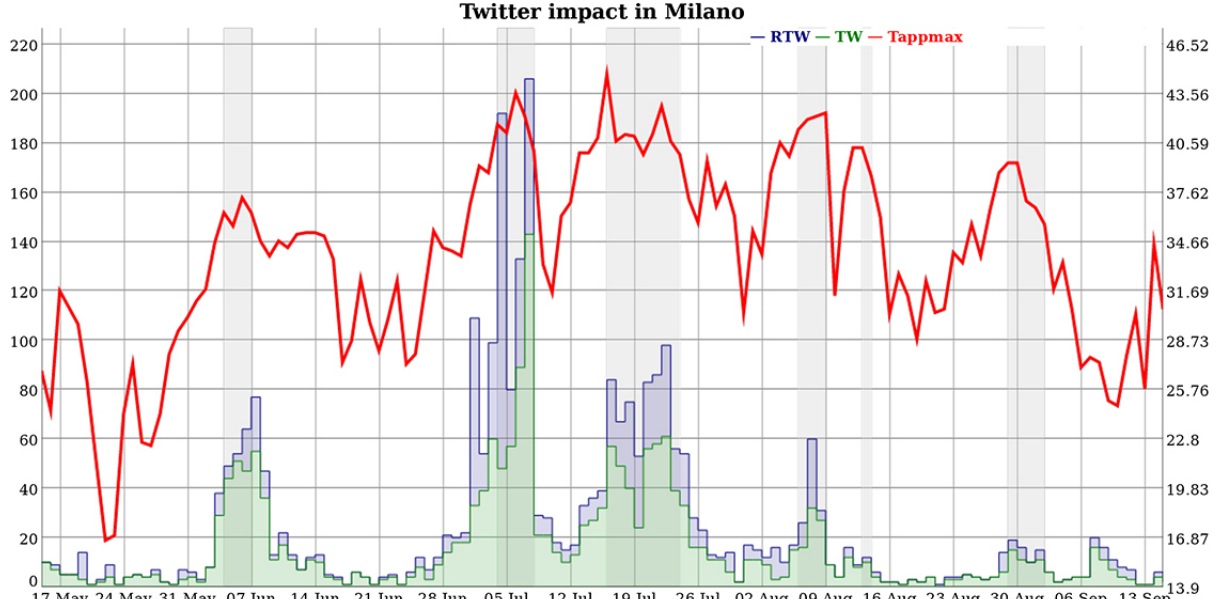
Figure 3. The pattern of the daily number of tweets (green histogram) and retweets (blue histogram) and the daily maximum apparent temperatures (red line) and the heat-waves periods (transparent blue bars) for Milan.